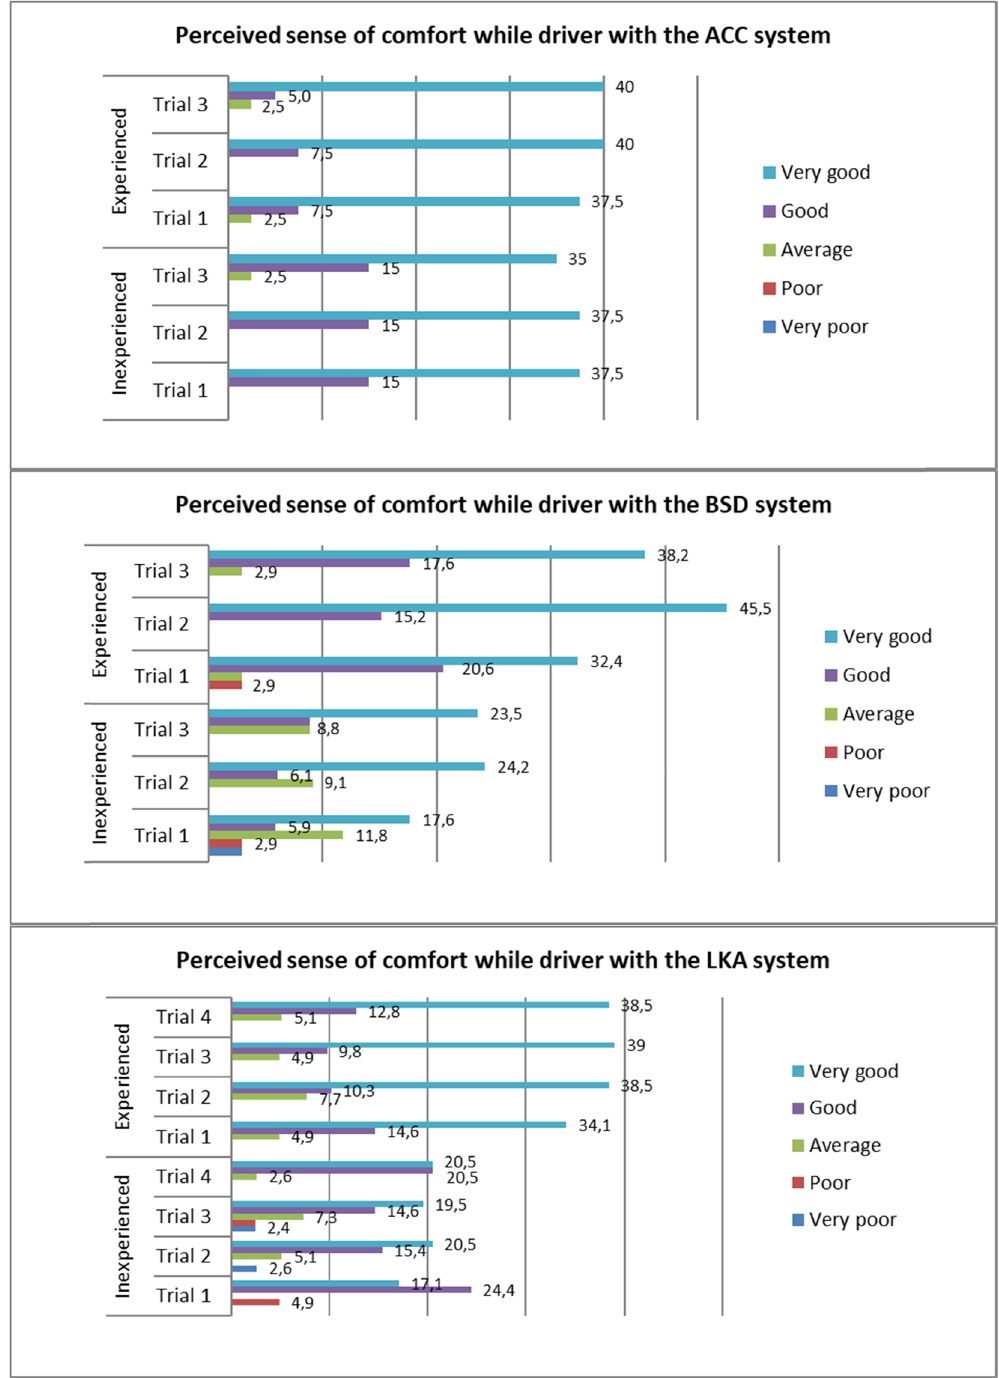
Figure 10: The sense of comfort felt by the experienced and inexperienced drivers during research drive ( % ) . Source: author ’ s own